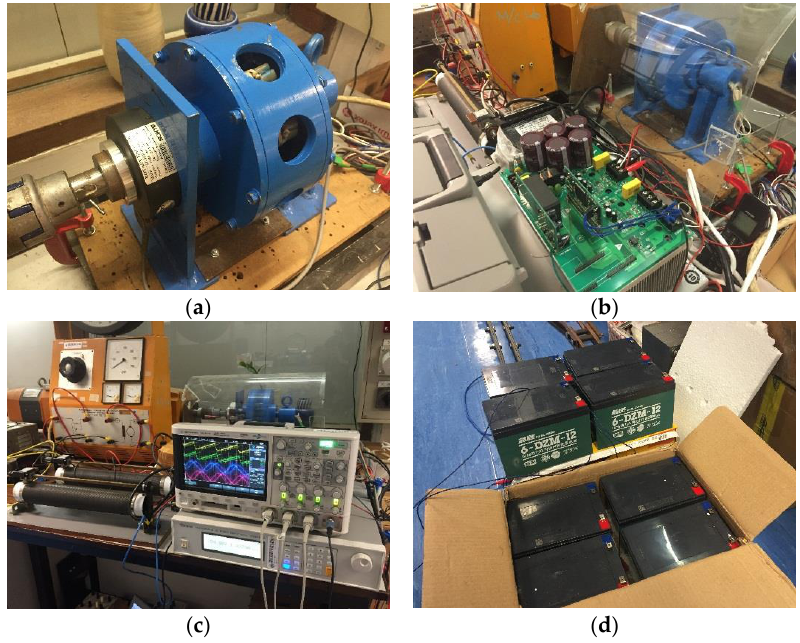
Figure 9. Proposed AFPM-VM and experimental setup. ( a ) Proposed machine; ( b ) Convertor used to drive the AFPM-VM; ( c ) DC machine, Oscilloscope and the DC power supply; ( d ) Battery system.